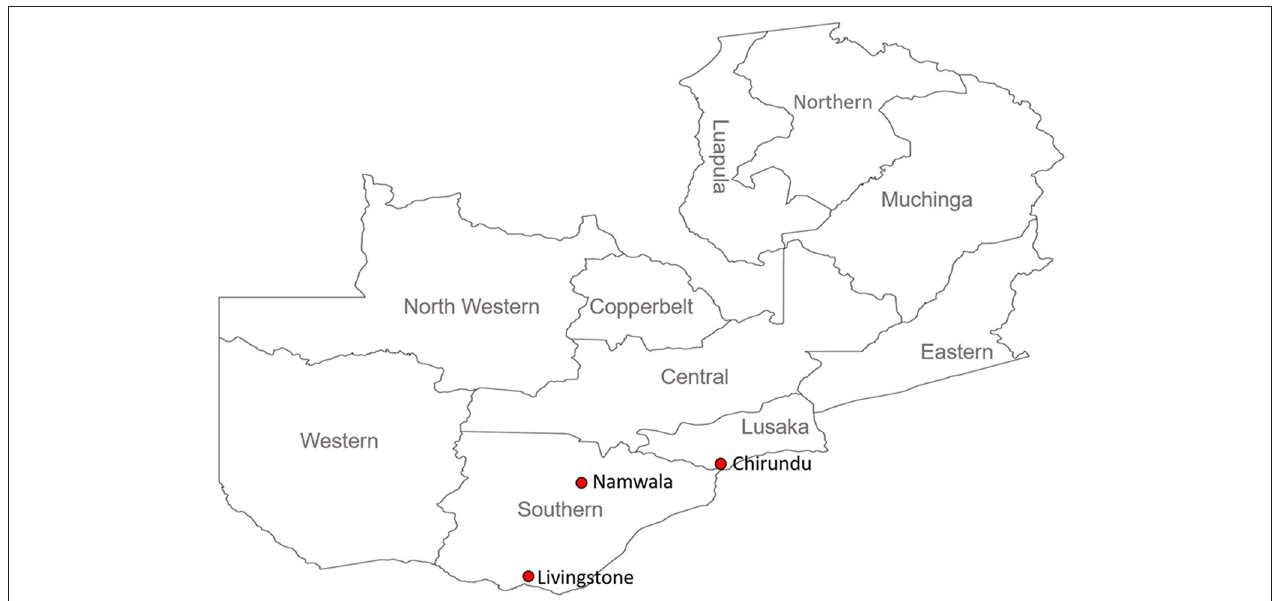
FIGURE 1 | Map of Zambia showing the study sites (Red dots) in southern Zambia. Sampling sites covered Lusaka (Chirundu) and Southern Provinces (Namwala and Livingstone).